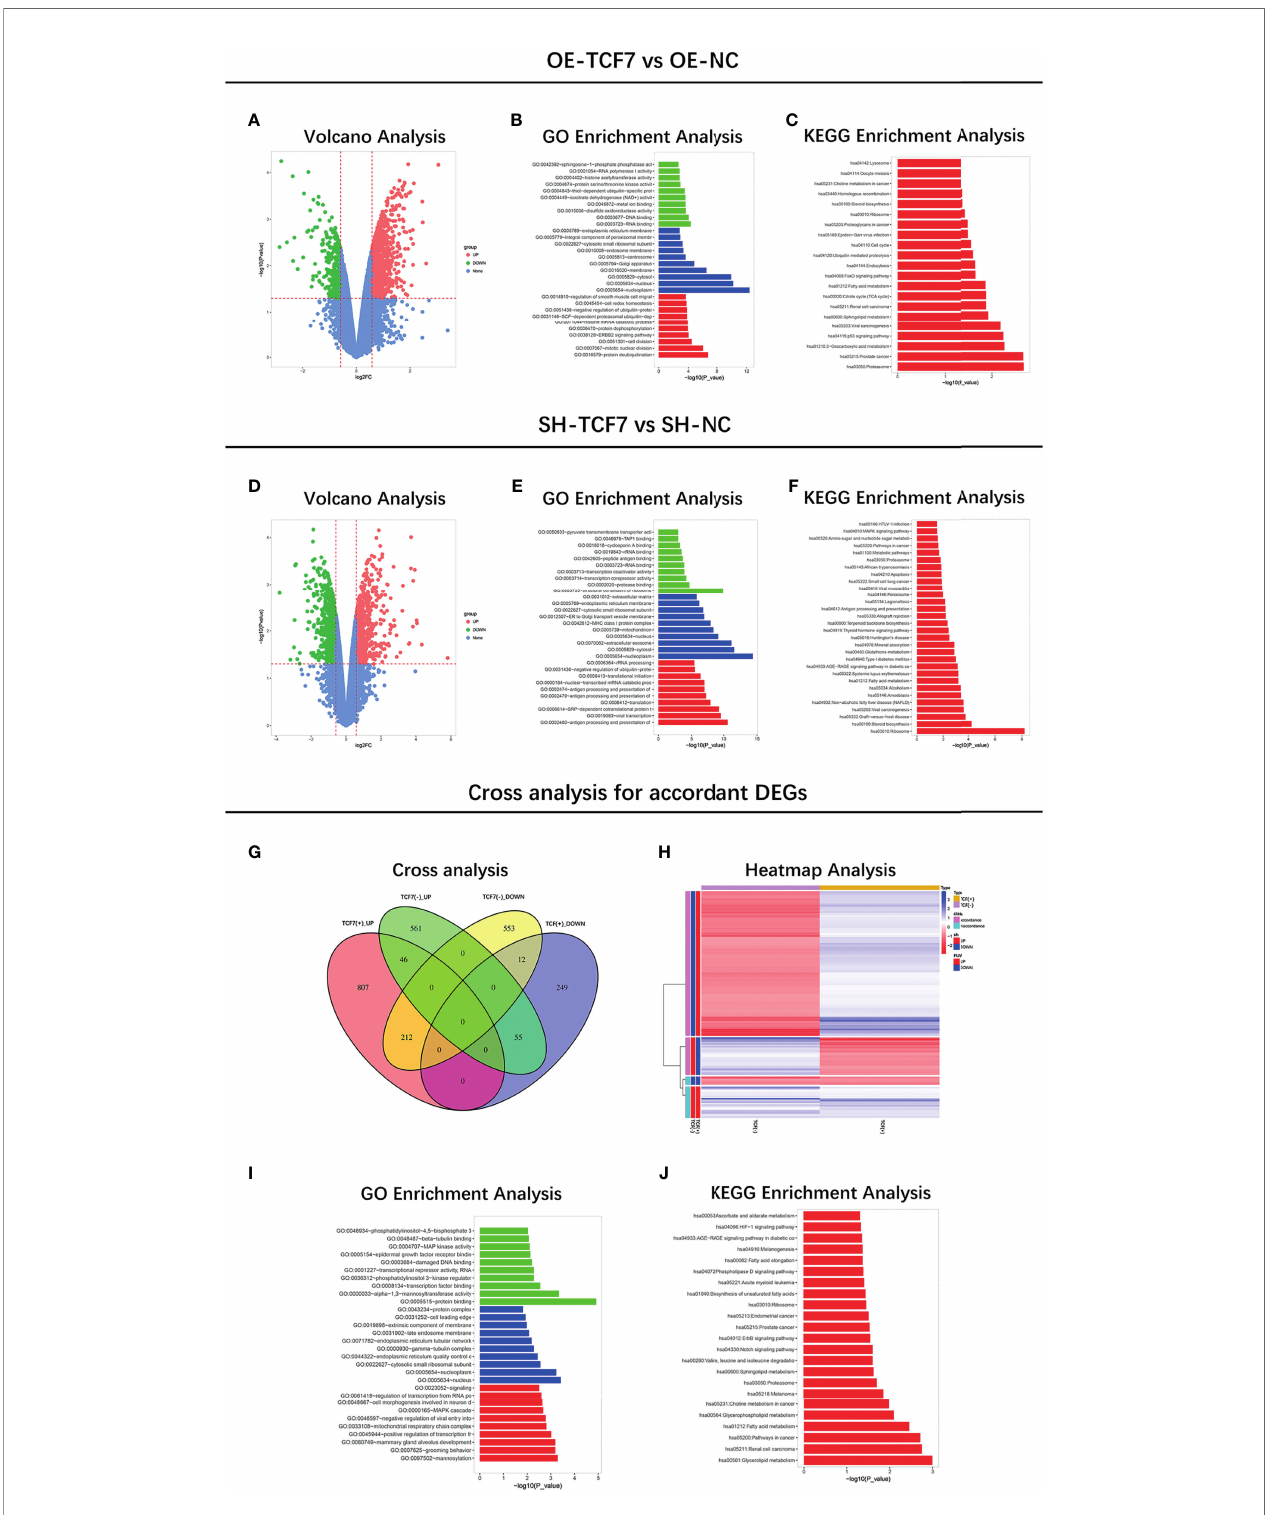
FIGURE 3 | Microarray analysis. Volcano plots (A) , GO enrichment (B) , KEGG enrichment (C) of mRNA pro fi le between OE-TCF7 group vs. OE-NC group; Volcano plots (D) , GO enrichment (E) , KEGG enrichment (F) of mRNA pro fi le between SH-TCF7 group vs. SH-NC group; Cross analysis (G) , Heatmap (H) , GO enrichment (I) , KEGG enrichment (J) of accordant mRNA pro fi